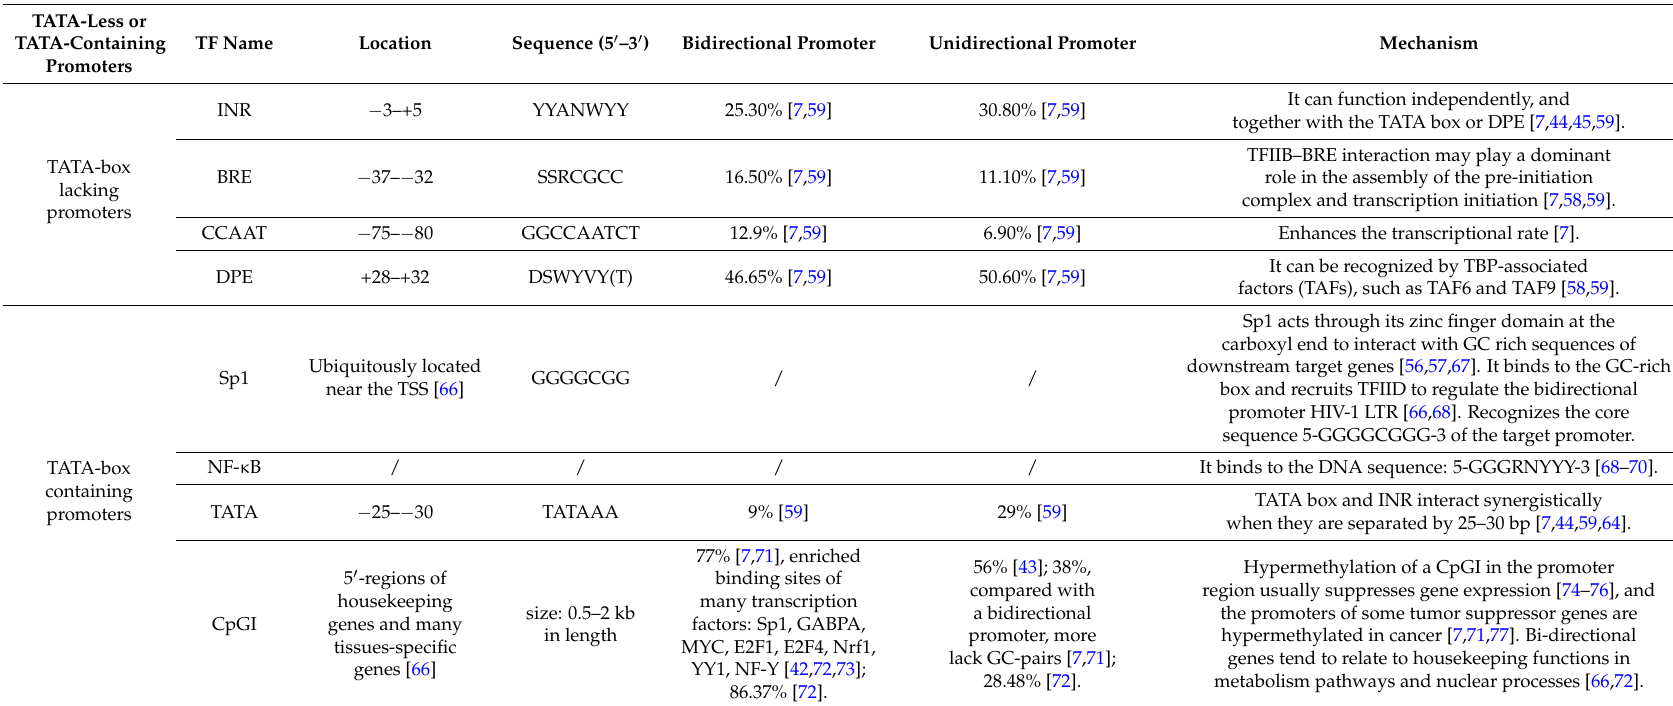
Table 1. Information of different transcription factors (TFs) in uni- and bi-directional